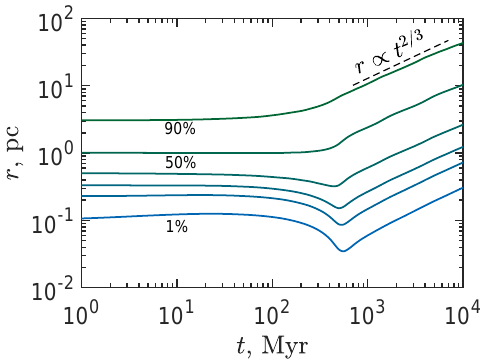
Figure 2. The evolution of mass shells is shown (the change with time of a radius which comprises a fixed fraction of the cluster mass). The curves from bottom to top correspond to 1, 5, 10, 20, 50, and 90 percent of the cluster mass,